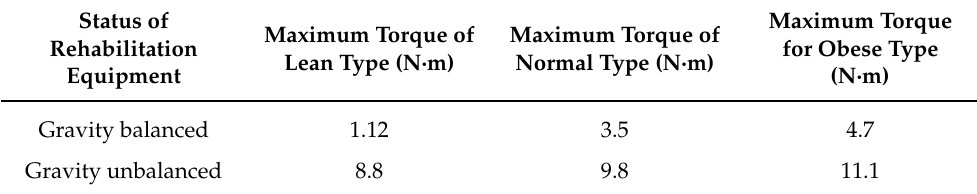
Table 8. Comparison of maximum moments during knee